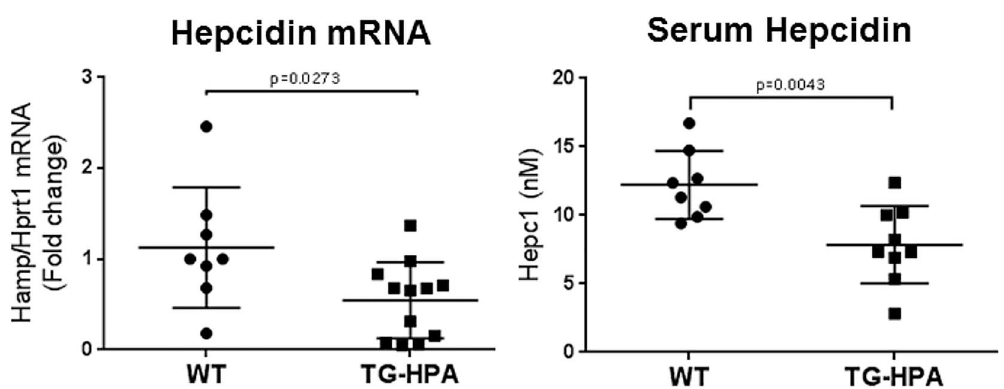
Fig 4. Transgenic mice overexpressing heparanase showed reduced liver hepcidin mRNA and serum protein. (A) Liver hepcidinmRNA levels of wild type (WT) and transgenicHPA mice (TG-HPA) normalizedto Hprt1. The values are expressedas fold change of wild type mice. (B) Quantification of serum hepcidinby SELDI-TOF in the same